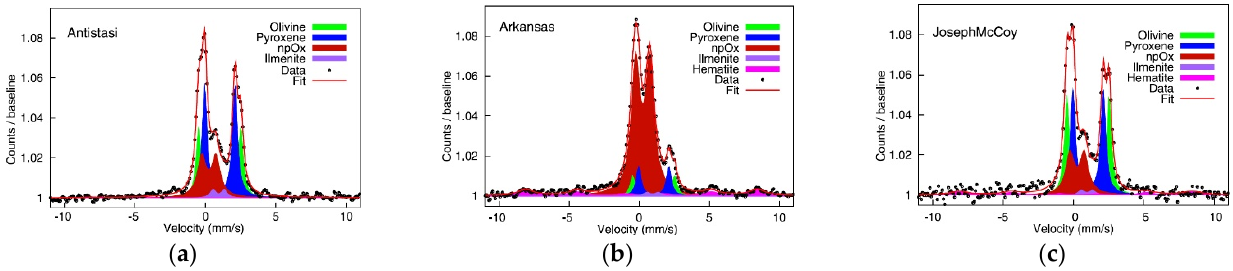
Figure 50. Mössbauer spectra of cobbles from Arkansas group at the Meridiani Planum, Mars: Antistasi ( a ), Arkansas ( b ), and Joseph McCoy ( c ) measured by Opportunity rover. NpOx means nanophase ferric oxide. Adapted from [148].